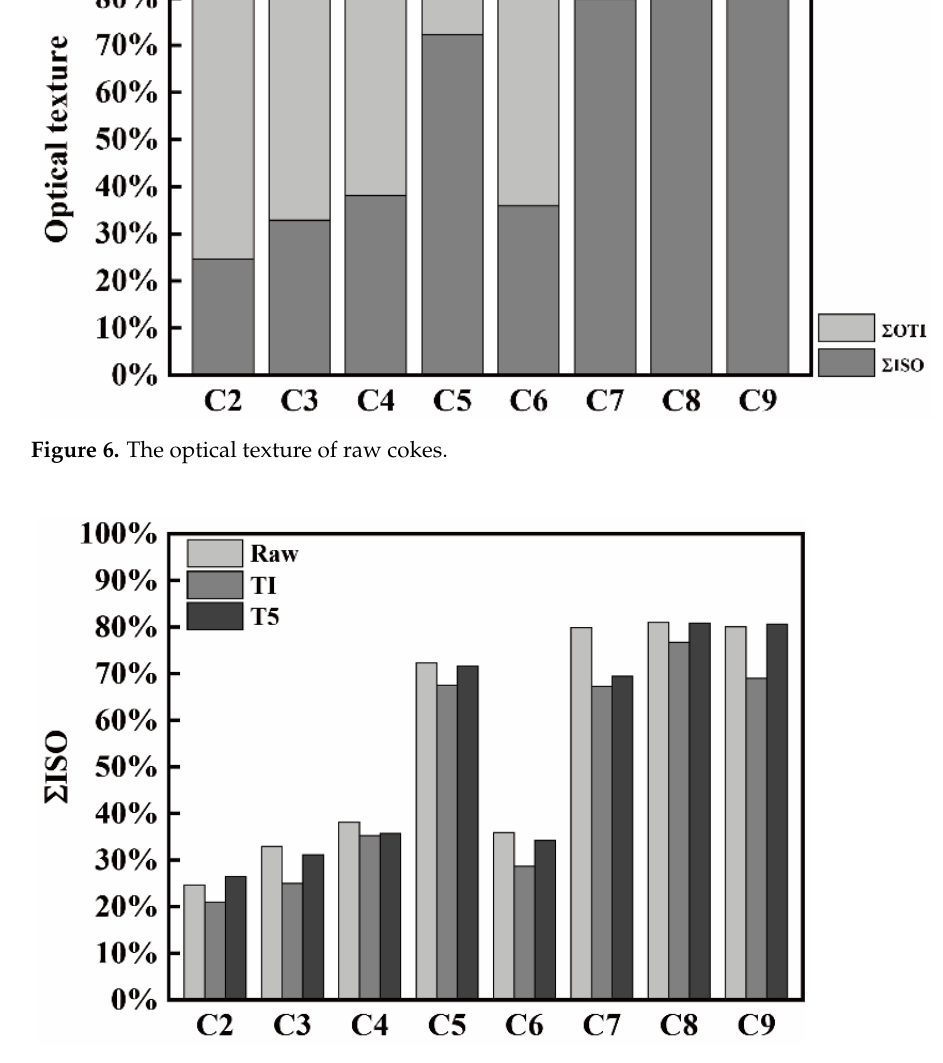
Figure 7. The Σ ISO of cokes under different conditions.